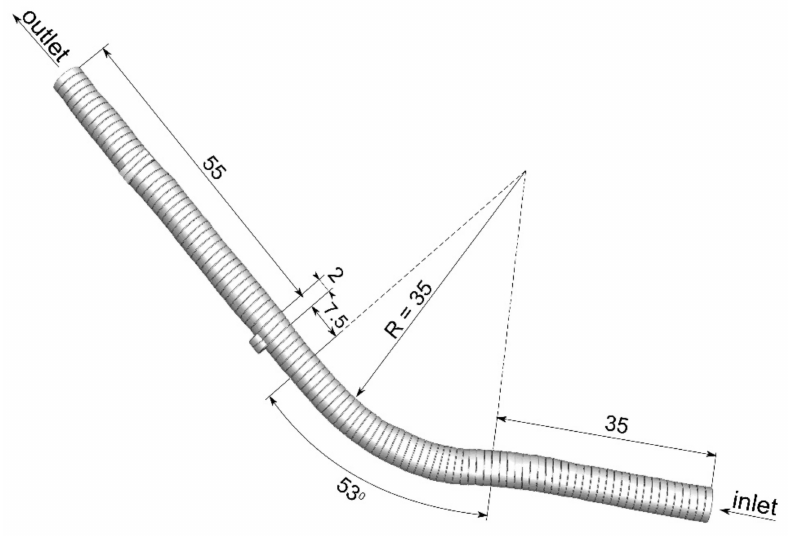
Figure 1. Numerical model geometry dimensioning—an ‘outside’ view.